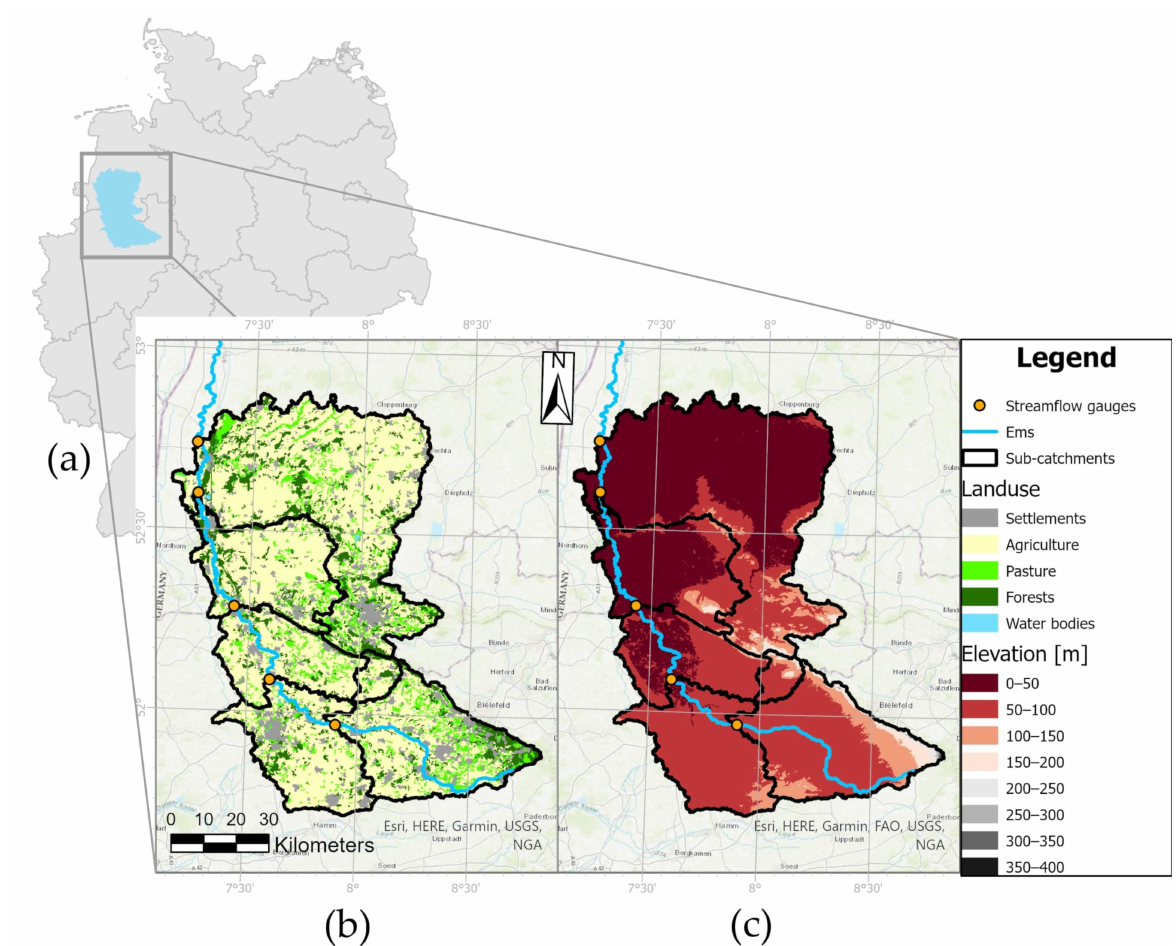
Figure 1. ( a ) Overview map of the study area location in Germany. ( b , c ) Maps of the river Ems showing the five individual sub-catchments delineated upstream from the last available streamflow gauge located 235 km downstream from the spring with its streamflow gauges, land use ( b ) and elevation ( c ). It appears that six separated catchments were delineated; yet, the smallest one actually has a connection to sub-catchment 2 on the bottom left